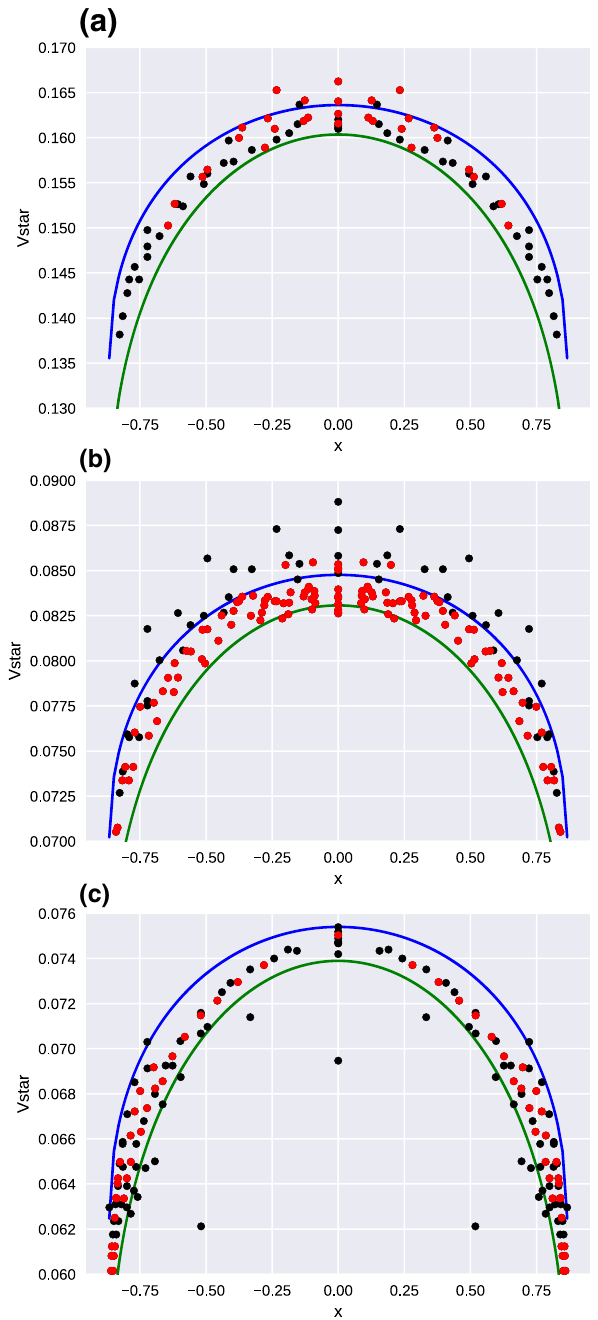
Fig. 3 Extractedvaluesofthehyperangularpartoftheconfiningpoten- − C ] for right triangles ( y = 0): tial V ∗ ( x , y ) = 1 / R [ V data − V fit fit Coul a β = 5 . 8, Ref. [10]; b β = 6 . 0, Ref. [10]; c β = 6 . 0, Ref. [11]. The black points correspond to all values of size R , whereas the red ones correspond to sizes R ≥ 7. The blue lines represent the (cid:2) -string prediction, the green lines the